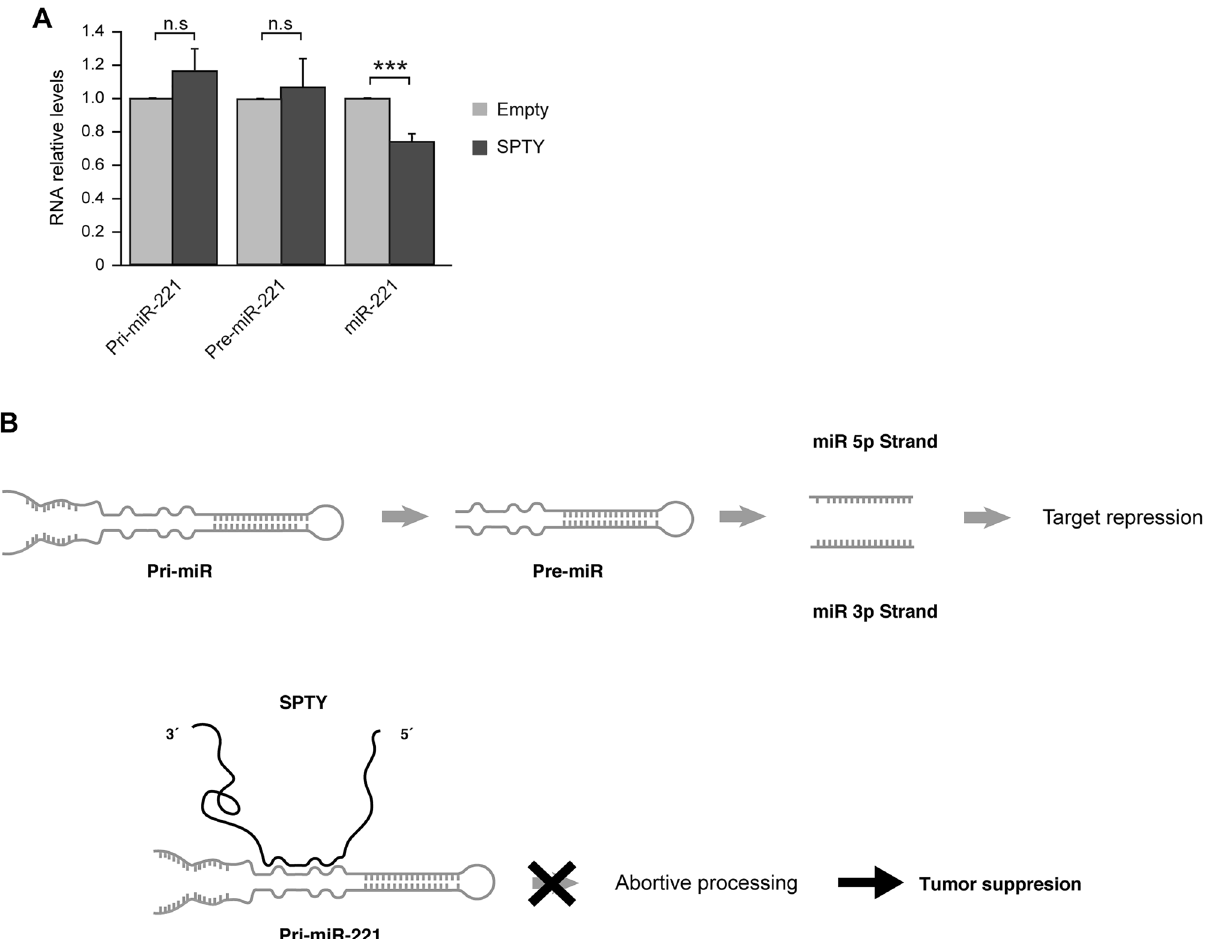
Figure 5. SPTY2D1-AS1 as a miRNA sponge of pri-miR-221. ( A ) pri-miR, pre-miR and miR-221 levels in Cal62 cells overexpressing SPTY2D1-AS1 (SPTY) relative to the empty vector-transfected control cells. ( B ) Schematic summary. SPTY2D1-AS1 is predicted to bind to pri-miR-221, disrupting miRNA biogenesis processing and decreasing the levels of mature miR-221. As miR-221 is considered an oncomiRNA, its downregulation may result in the tumor suppressive features of SPTY2D1-AS1 expression. Values represent mean ± SD. ***p < 0.001, n.s. not culture medium with 0.2% FBS. Around 3.5 × 10 4 cells were placed in the upper chamber 48 h after transfec- tion. The lower chamber contained 0.75 mL of medium with 20% FBS as a chemoattractant. Cells were allowed to invade to the lower chamber, and the cells that remained on the upper chamber were removed with a cotton swab; filters were fixed in 4% paraformaldehyde and stained with crystal violet. Using image J, five fields were quantified for each condition and the number of cells migrated to the lower surface was counted. In vivo study. Animal experimentation was performed in compliance with the European Community Law (86/609/EEC) and the Spanish law (R.D. 1201/2005), with the approval of the CSIC ethics committee. The study was carried out in compliance with the ARRIVE guidelines. Xenotransplants were established in 6-week-old immunocompromised female Hsd:Athymic Nude-Foxn1nu mice (Envigo) by subcutaneous injection in both flanks of 1 × 10 6 Cal62-luc cells constitutively overexpressing the SPTY expression vector (or the empty vector) and suspended in 50 μL of phosphate buffered saline mixed with 50 μl of Matrigel (Corning). In total, 11 tumors were established (Empty vector n = 5 and SPTY n = 6). Tumor bioluminescent signals were determined in vivo at the indicated time points to calculate tumor growth. To do this, 50 μL of a 40 mg/mL solution of Xeno-Light D-Luciferin- K + Salt Bioluminescent Substrate (Perkin Elmer) was subcutaneously injected into each mouse at each time point. At 10 min post-injection, mice were anesthetized and imaged with the IVIS-Lumina II Imaging System (Caliper Life Sciences). At the final time point (day 31), tumors were excised and weighed. Statistical analysis. Results are expressed as the mean ± SD of at least three different experiments per- formed in triplicate. Results from the in vivo studies are expressed as the mean ± SEM. Statistical significance was determined by Student’s t-test analysis (two-tailed) and differences were considered significant at a P-value < 0.05.